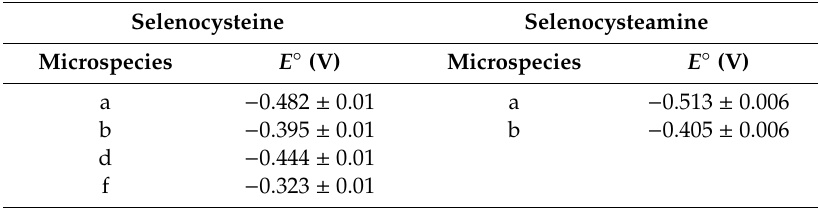
Table 4. The species-specific standard redox potential values for every microspecies of selenocysteine and selenocysteamine given as mean ± standard